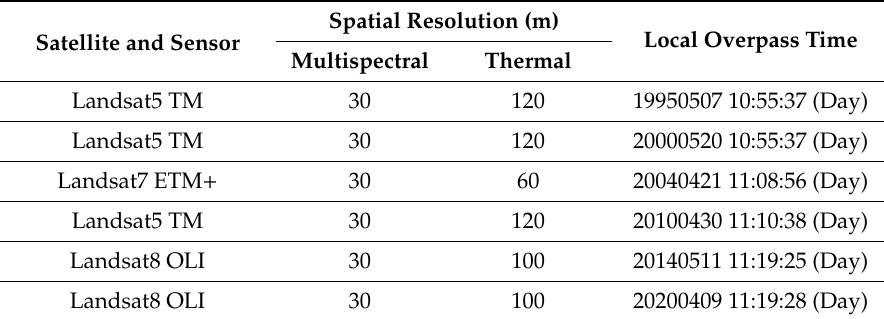
Table 1. Landsat images